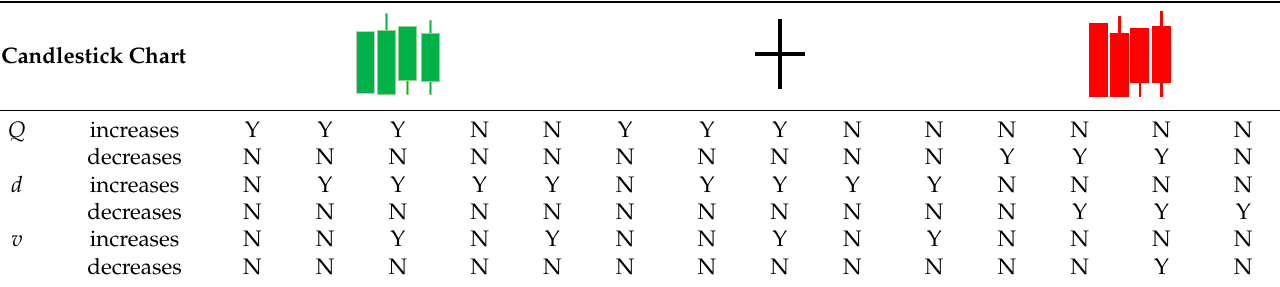
Table 1. Nine basic patterns of the candlestick charts.